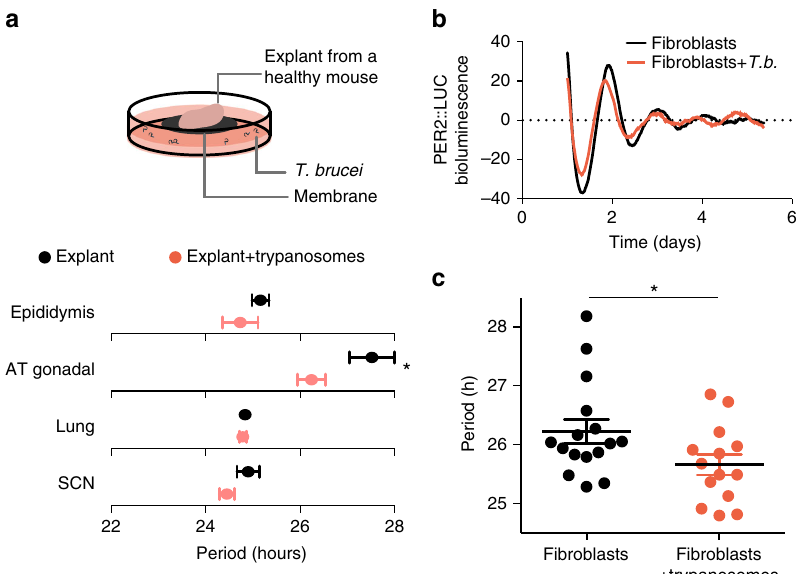
Fig. 6 T . brucei presence is suf fi cient to shorten the period. a Period plot of various tissues harvested from healthy PER2::LUC mice and cultured with medium only (black) or 10 5 T. brucei (orange). Shown are mean period ± s.d.; *adjusted p < 0.05 FDR method Benjamini – Hochberg. b Representative records of bioluminescence reporting of circadian expression from PER2::LUC ear fi broblasts co-cultured with 10 5 T. brucei ( T.b ., orange). c Period comparison from PER2::LUC ear fi broblast with medium (black, n = 16) and co-cultured 10 5 T. brucei (orange, n = 14). Unpaired t- test, * p < 0.05, from four independent